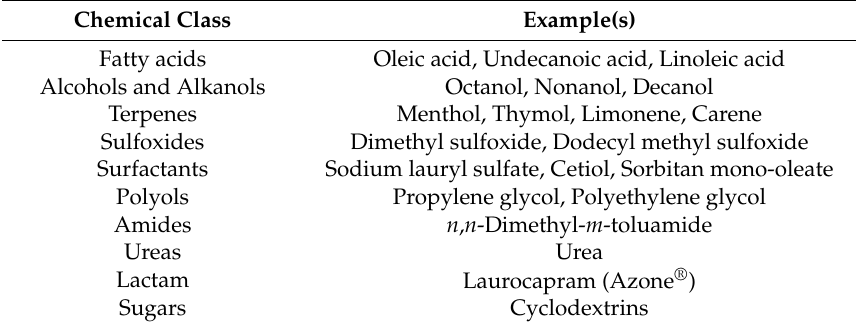
Table 1. Permeation enhancers and their chemical